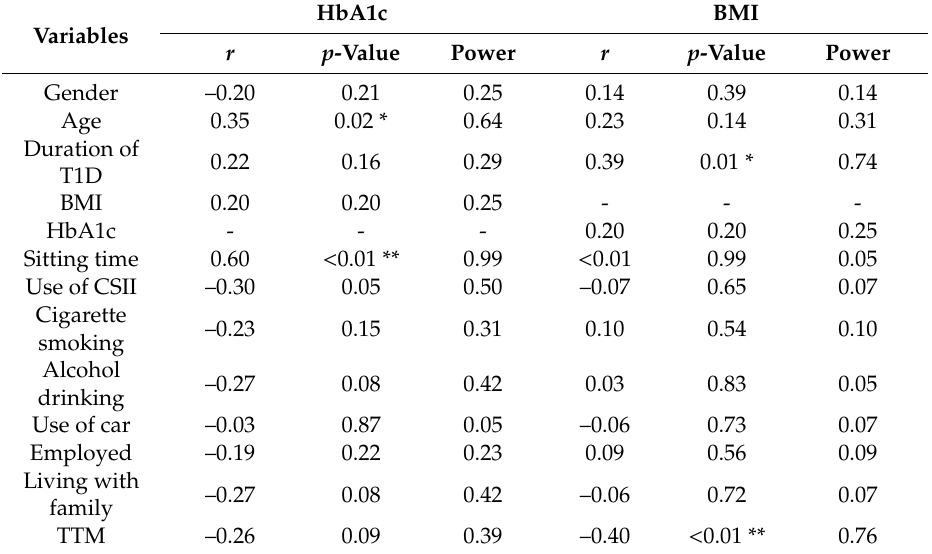
Table 2. Correlations among HbA1c, BMI, and other